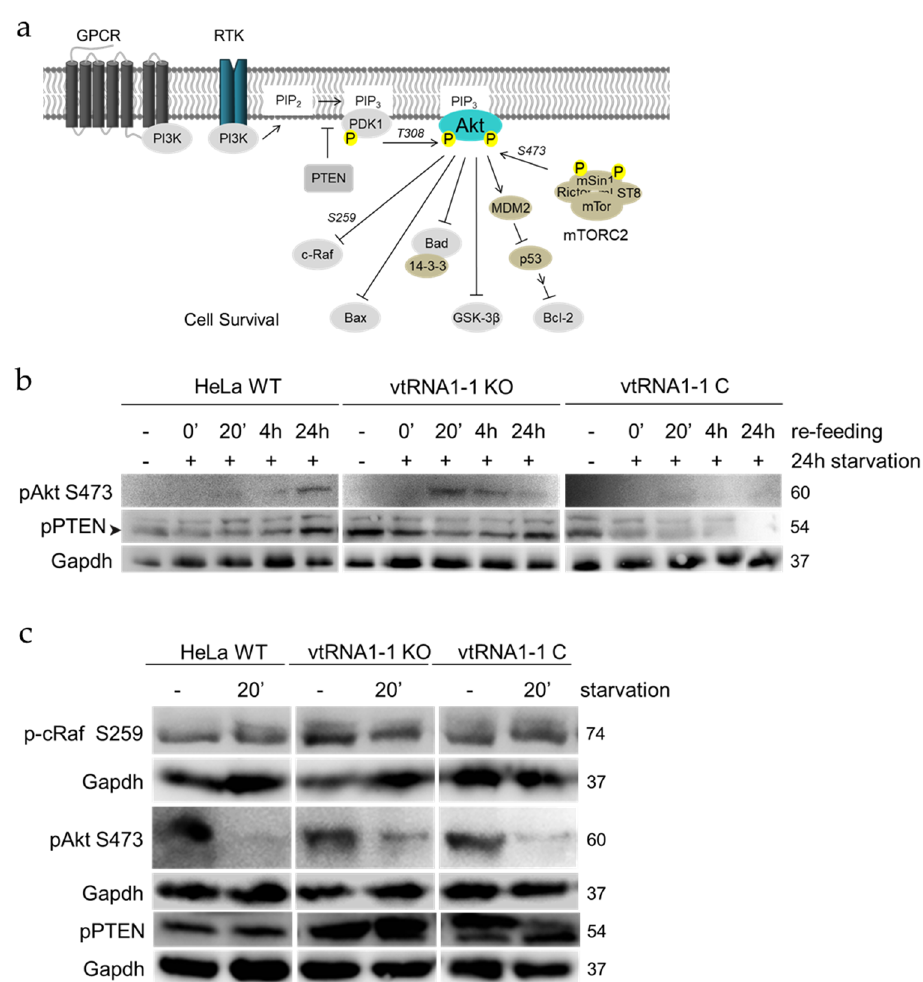
Figure 4. The loss of vtRNA1-1 stimulates PI3K/Akt signaling. ( a ) Simplified schematic representation of the PI3K/Akt signaling pathway. The kinase Akt is the main signal transducer. Important serine/threonine phosphorylations are indicated. ( b ) Western blot analysis was used to track the levels and the kinetics of mTORC2 phosphorylated Akt and phosphorylated PTEN as a consequence of 24 h starvation followed by re-feeding. Gapdh served as loading control. ( c ) Phospho-protein levels of the PI3K/Akt signaling involved proteins Akt and PTEN were assessed in the absence of starvation (−) and after 20 min of starvation with chloroquine (20′). Gapdh served as loading control.